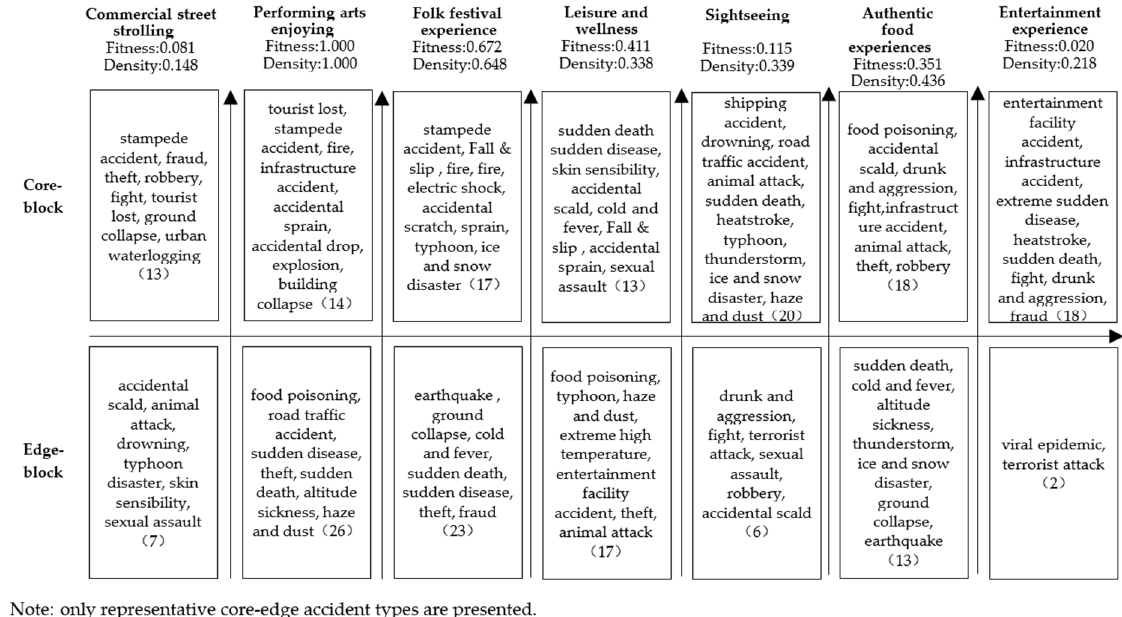
Figure 7. Core-edge structure of tourism accidents type in different product projects.